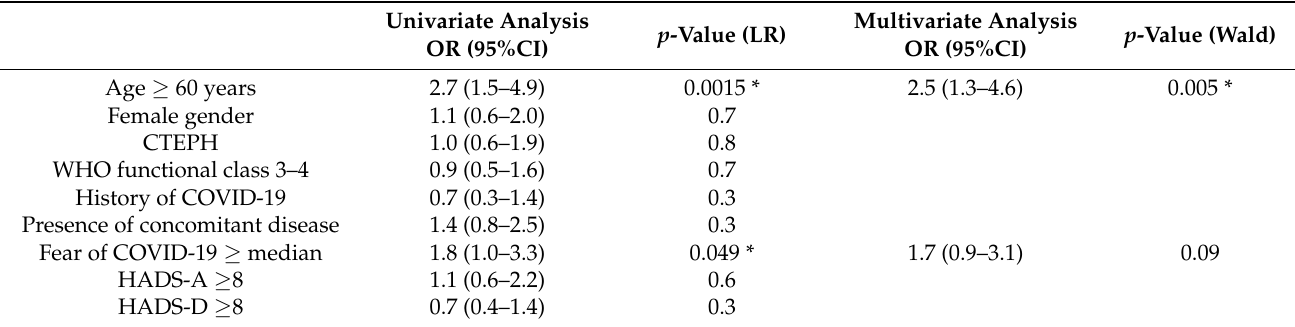
Table 2. Impact of demographic and clinical factors on the willingness to vaccinate against COVID-19 in PAH/CTEPH patients: results of the univariate and multivariate regression